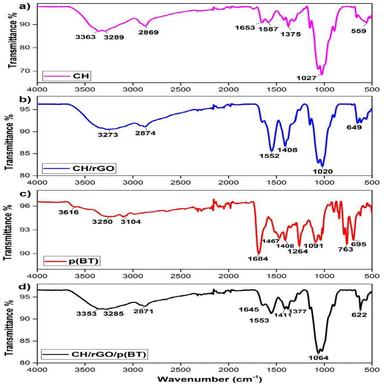
FTIR spectra of the materials a) CH b) CH/rGO c) p(BT) and d) CH/rGO/p(BT).